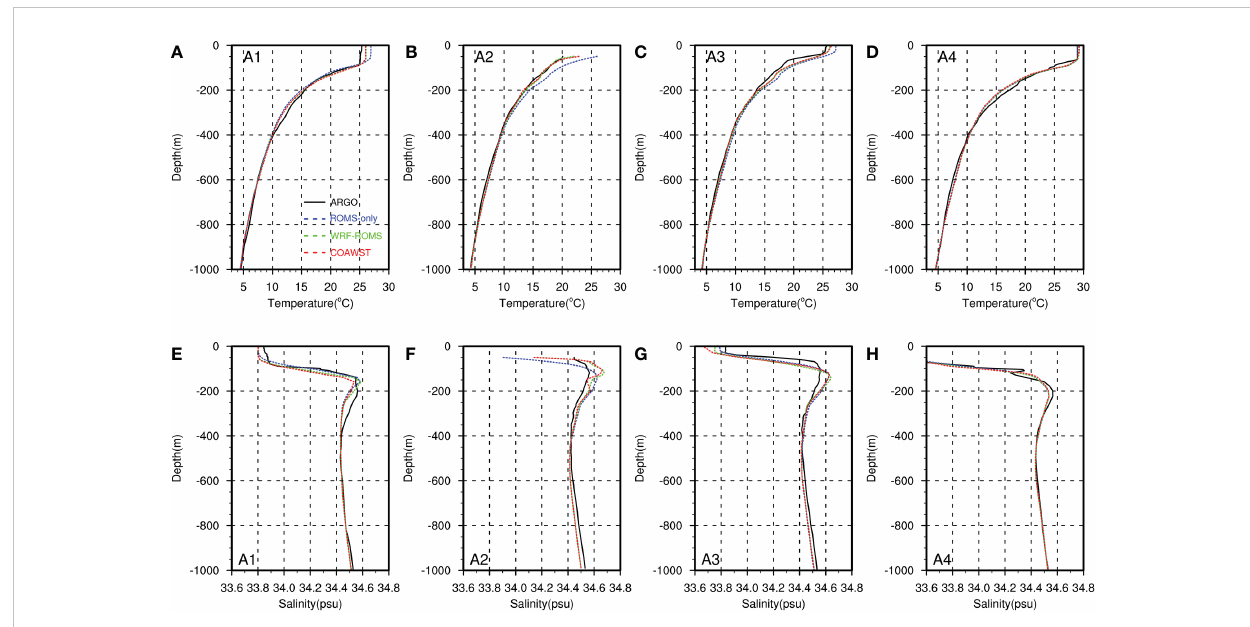
FIGURE 4 Comparison of temperature pro fi le (top) and salinity pro fi le (bottom) between observation and simulation at each position of Argo fl oats A1 (A, E) , A2 (B, F) , A3 (C, G) and A4 (D, H)